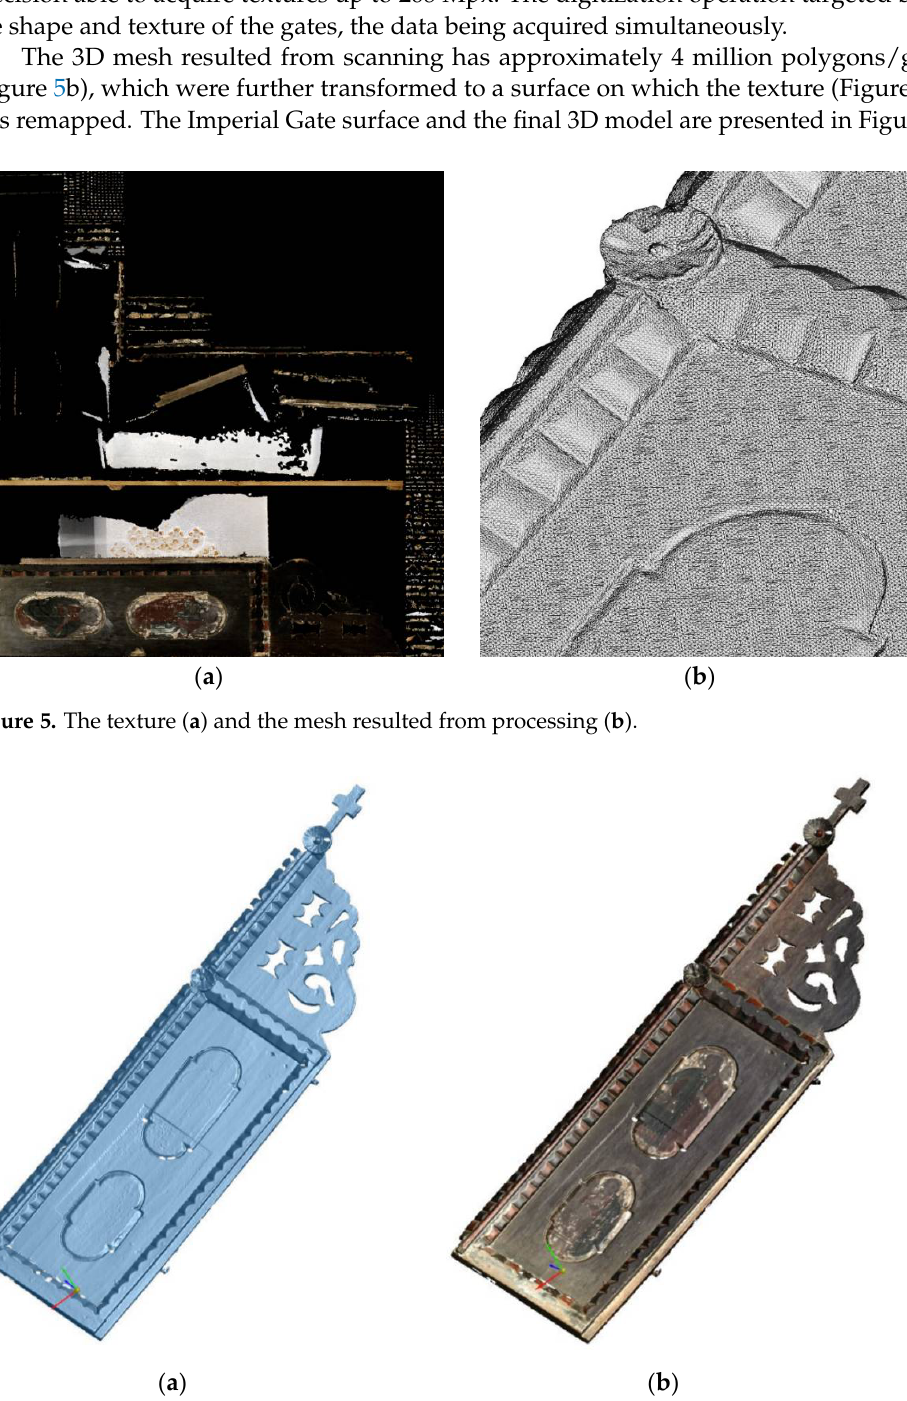
Figure 6. The Imperial Gate’s surface ( a ) and the final three-dimensional (3D) model ( b ).